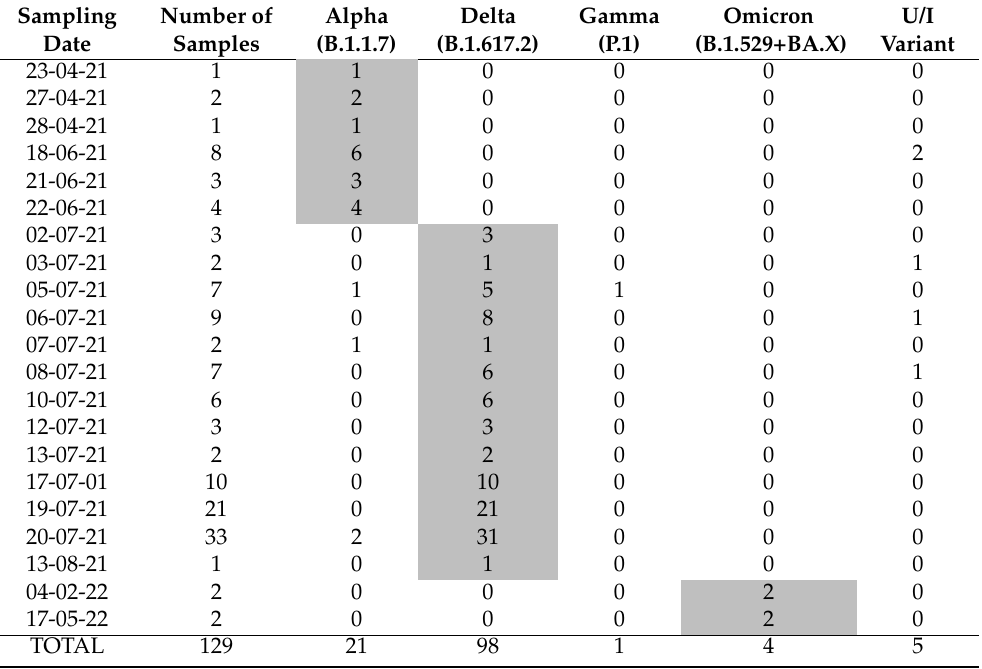
Table 2. SARS-CoV-2 variant identification by phylogenetic analysis of the selected S-gene 921 bp fragment determined from the RNA extracts of 129 clinical samples positive for